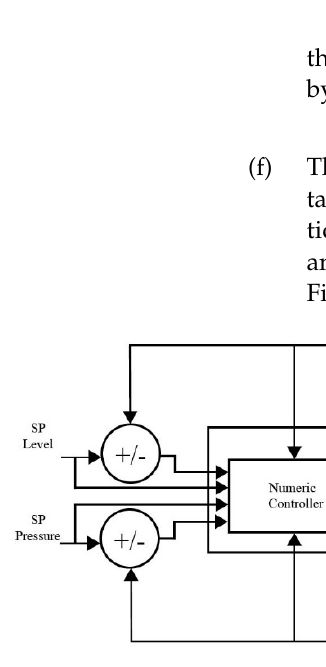
Figure 6. Diagram of implementation of numerical control loops.